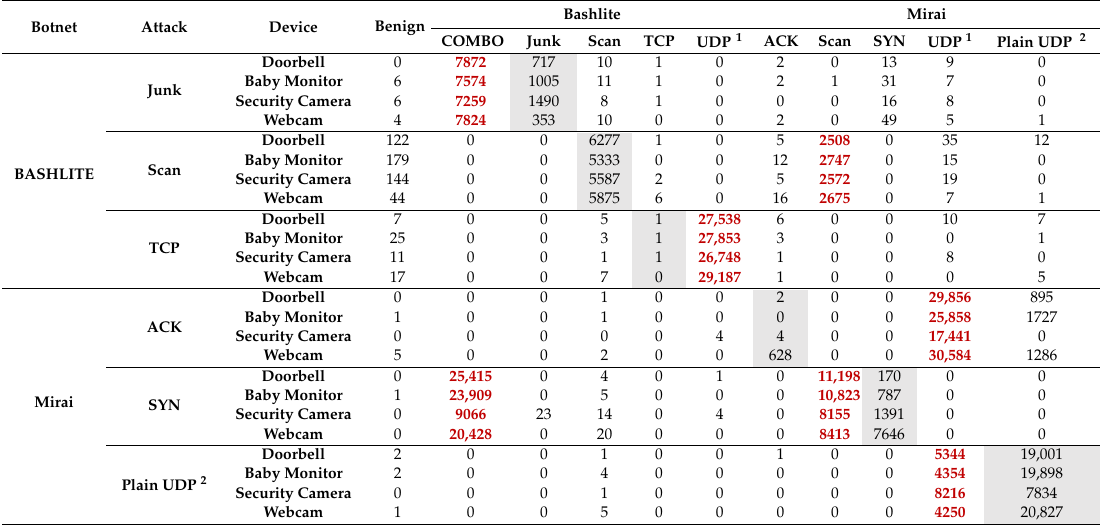
The red bolded numbers are large numbers of misclassified samples; Gray shaded numbers indicate samples that are correctly classified; 1 UDP: UDP flooding; 2 Plain UDP: Less of an option of UDP flooding for higher packets per second.